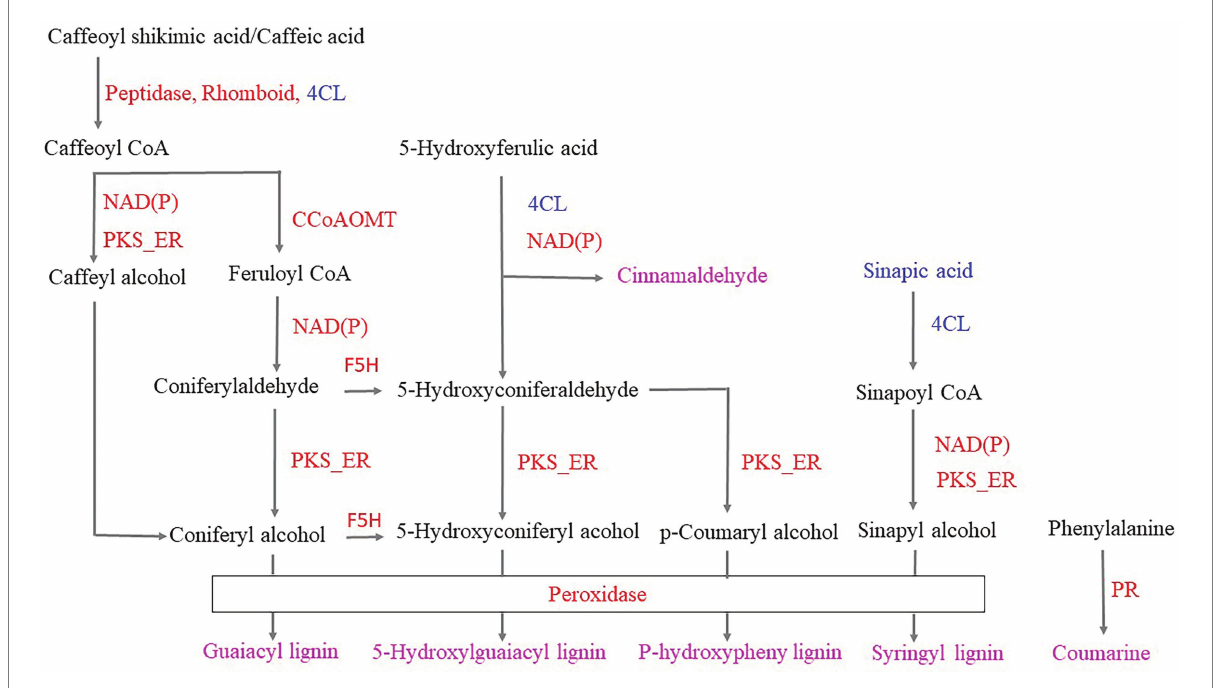
FIGURE 8 Responses of the phenylpropanoid biosynthetic pathway to infestation with tea green leafhoppers. Note: red proteins represent upregulation; blue proteins represent downregulation; pink metabolites were obtained in response to tea green leafhopper. PR: protein kinase; 4CL: 4-coumarate- CoA ligase; NAD(P): NAD(P)-bd_dom domain-containing protein; PKS_ER: PKS_ER domain-containing protein; Peptidase: peptidase_M16 domain-containing protein; Rhomboid: rhomboid domain-containing protein; CCoAOMT: caffeoyl-CoA